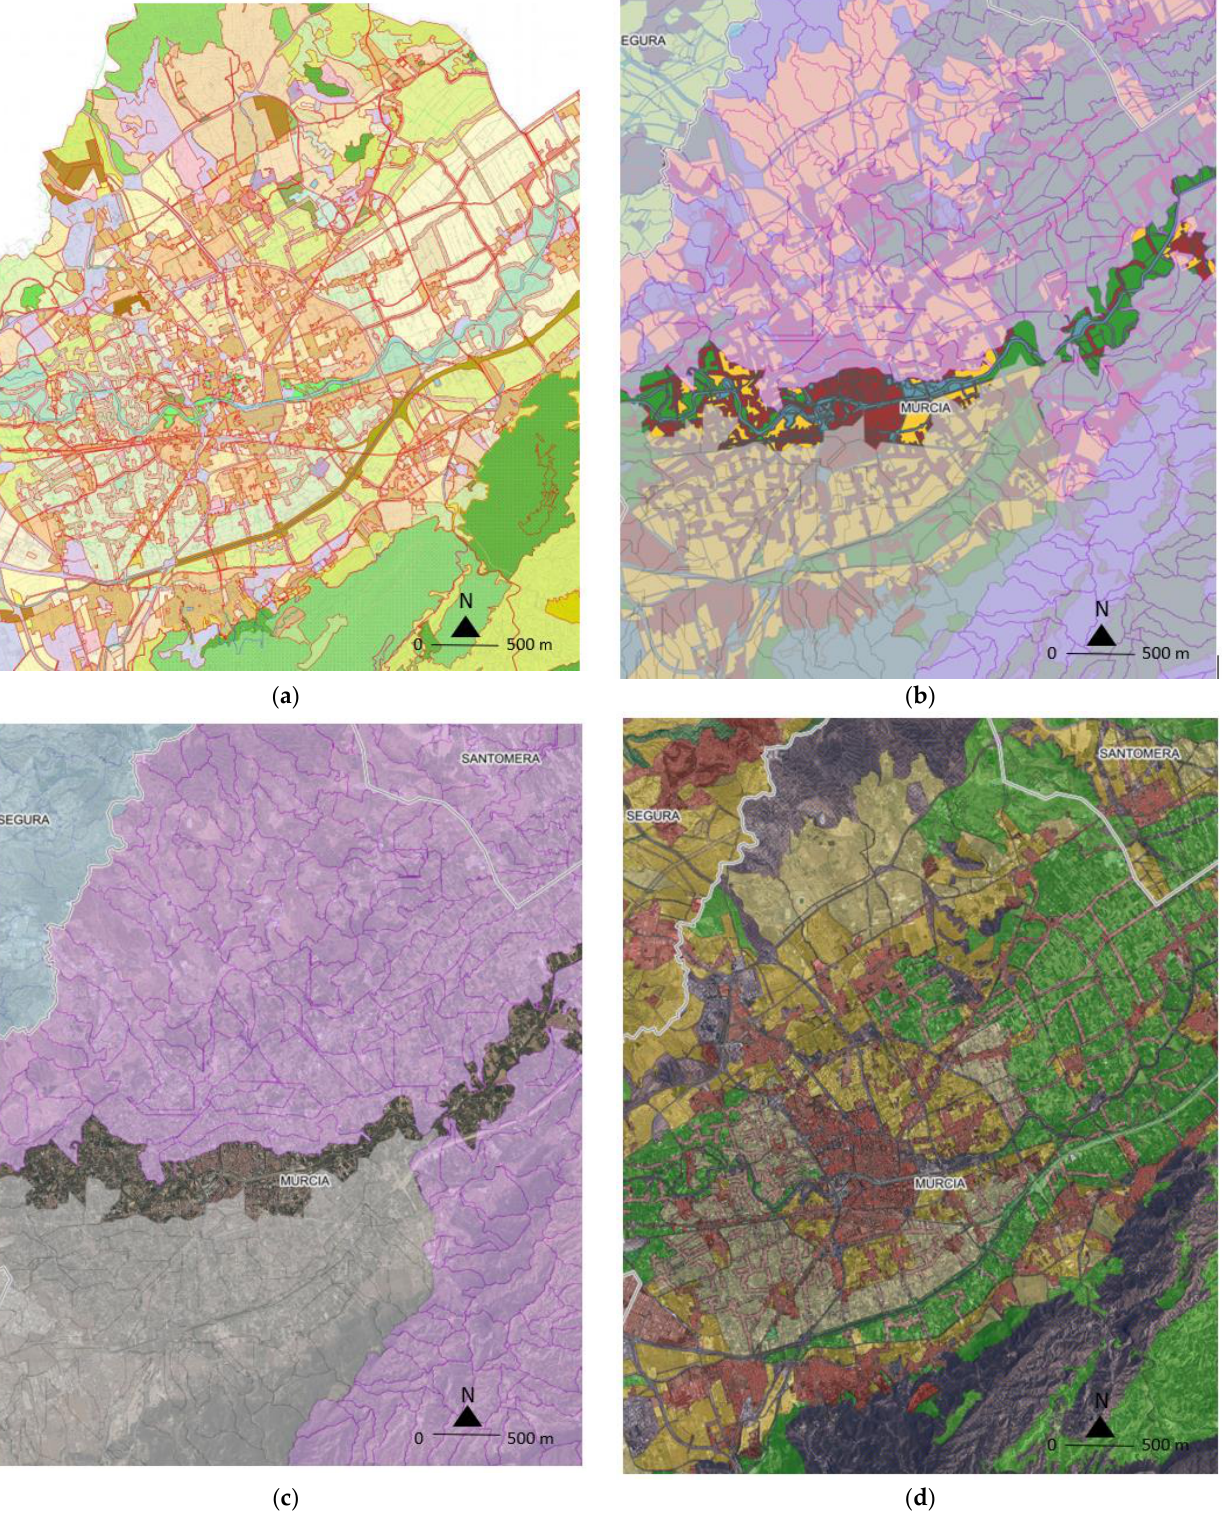
Figure 8. Generation of discrete homogeneous orographic-urban units (HOUU) for spatial analysis: ( a ) zoning map of urban planning uses of the Murcia masterplan; ( b ) current orthophoto of the city of Murcia with a layer superimposition of sub-basins of homogeneous orography; ( c ) superposition of layers of homogeneous sub-basins and classification by masterplan land planning classes and ( d ) homogeneous orographic-urban planning units generated.